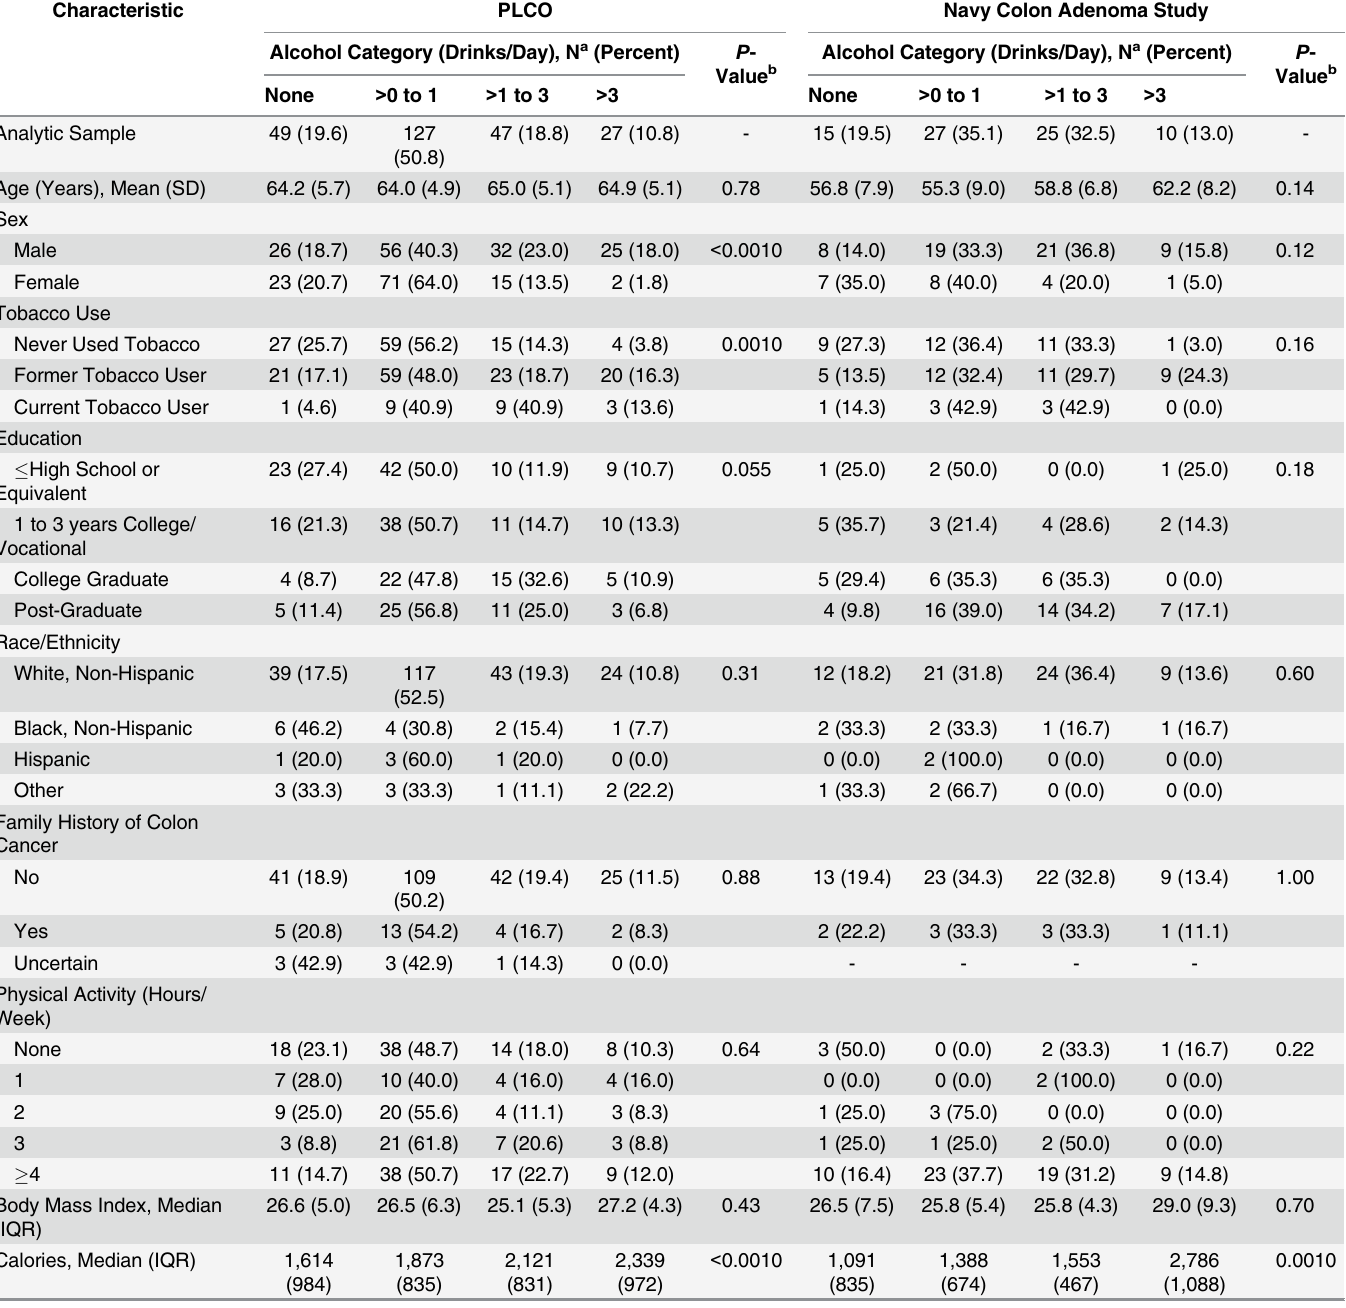
Table 2. Selected Characteristics Among Controls by Categories of Alcohol Consumption in 250 US Adults (PLCO) and 77 US Adults.